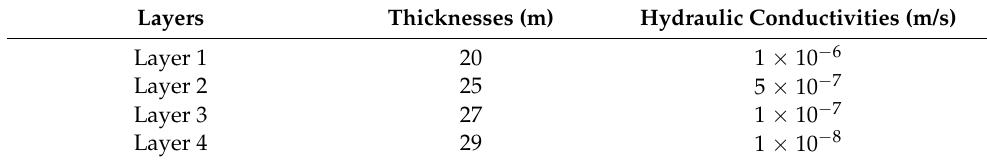
Table 1. Each layer’s hydraulic conductivities and thicknesses.